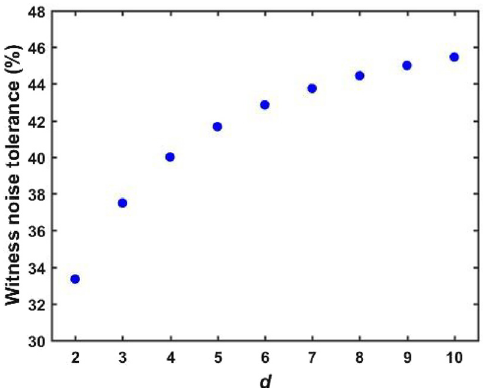
Figure 8: Noise tolerance of the witness as a function of the quantum state level d , given a fi xed number of parties N = 4. We can observe that the witness robustness toward white noise increases with a growing number of levels. While we report here only up to d = 10, such a tolerance saturates at 50% for d → ∞